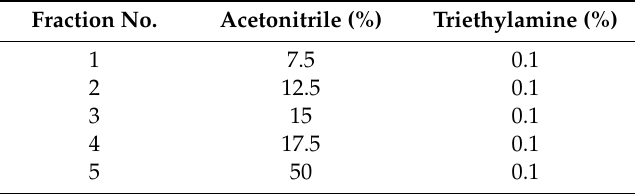
Table 1. Elution solutions for fractionation of digest